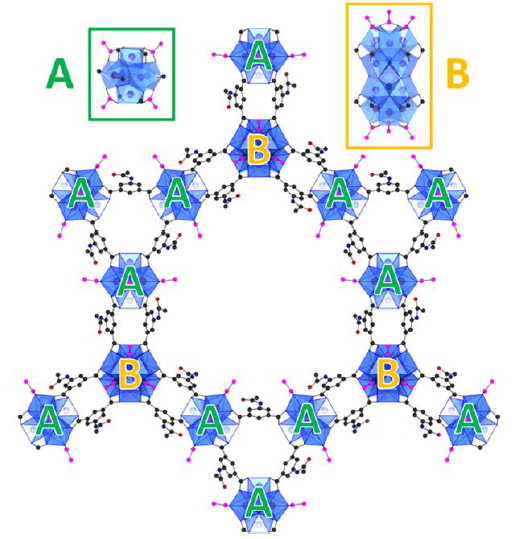
Figure 5. Inorganic building units (IBUs) of CAU-45 and interconnection to a layered motive via 5- acetamidoisophthalate ions. ( A ) Hexanuclear clusters. ( B ) Dodecanuclear clusters. Zirconium−oxygen clusters: blue; linker carbon: black; acetate carbon: pink; oxygen: red; nitrogen: dark blue; hydrogen: not displayed [93]. Reproduced from ref. [93] with permission from the American Chemical Society, copyright 2020.